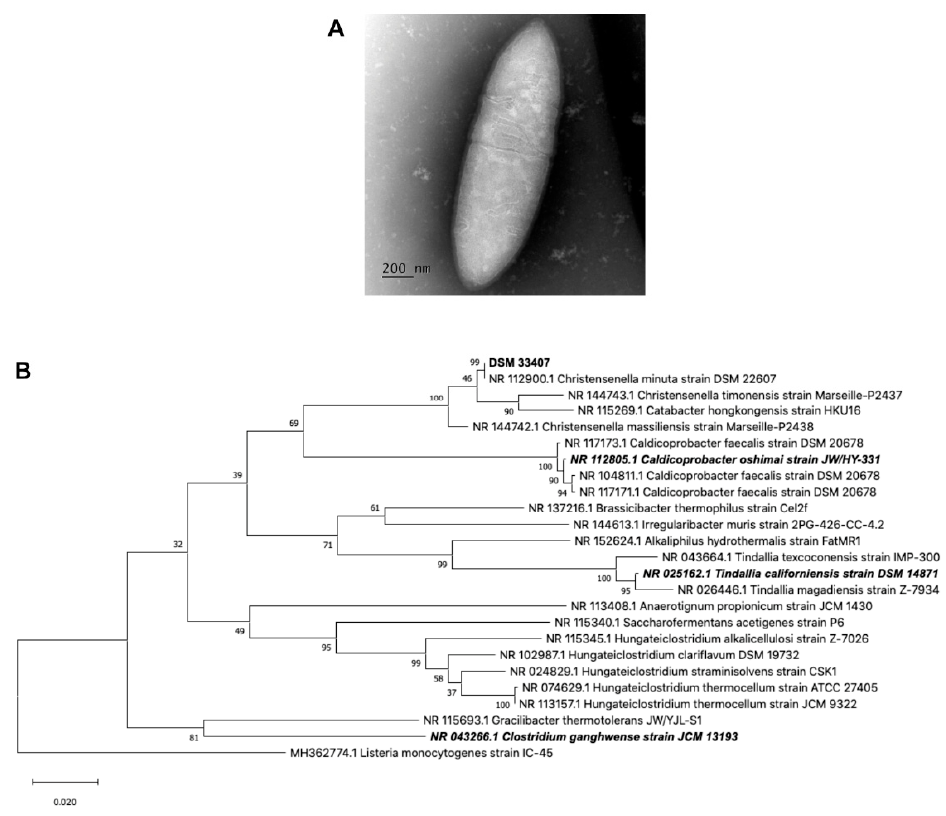
Figure 1. Classification of new strain DSM33407 as a strain of Christensenella minuta . ( A ) TransmisScheme 33407. ( B ) Maximum likelihood tree showing the closest relative of strain DSM33407 based on 16S rRNA gene sequence. Listeria monocytogenes strain IC-45 was used as outgroup. Numbers on the branches are bootstrap values validated using 1000 iterations. In bold is the DSM33407 16S rRNA sequence; in bold and italics are the 16S rRNA sequences identi- fied as closely related to C. minuta DSM 22607 in the original type strain publication by Morotomi et al. based on 16S rRNA sequences